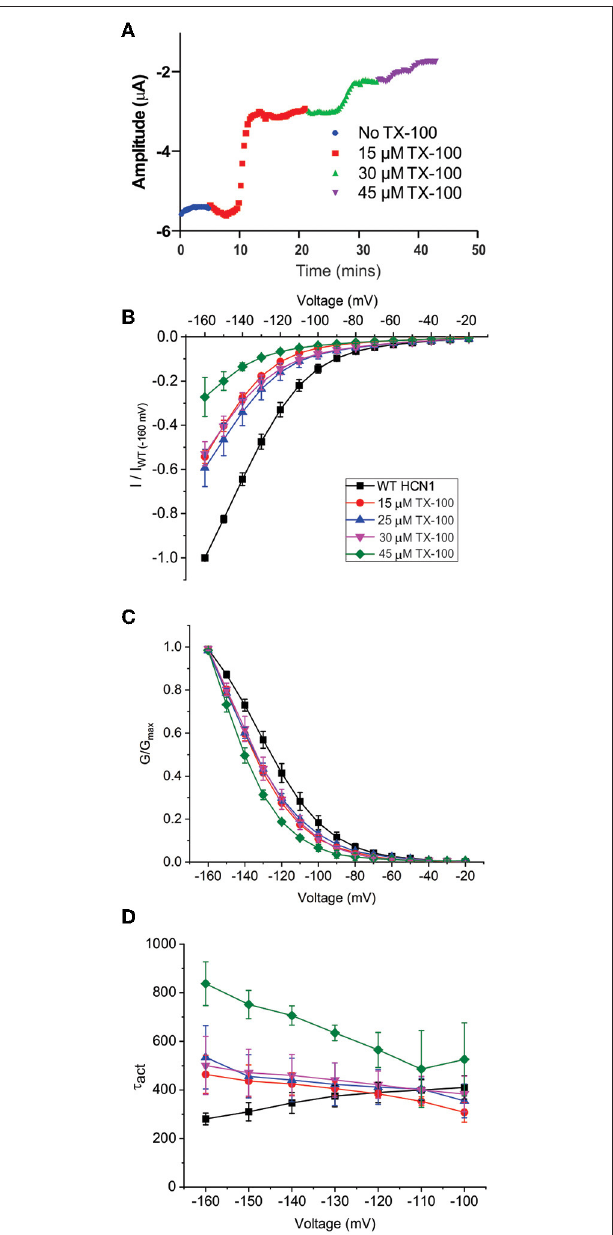
FIGURE 6 | Changes in membrane fluidity do not account for cannabinoid regulation of HCN1. Membrane fluidity was altered by the addition of Triton X-100 (TX-100) to the bath solution. (A) Representative time course of the steady-state current following the application of TX-100 at different concentrations, indicating that increasing membrane fluidity decreases HCN1 channel activity. However, this decrease in HCN1 current occurs more rapidly (within 1–2min) than the decline observed with THC (which occurs over the course of 10–30min). (B) Current-voltage relationship of HCN1 upon the addition of 0, 15, 25, 30, and 45 µ M TX-100 normalized to maximal current (I WT( − 160mV) ). (C) TX-100 induces a − 10 to − 15mV hyperpolarizing shift in the steady-state voltage-dependence of HCN1, which does not occur when THC or CBD is applied. (D) HCN1 activation kinetics are uniquely affected by TX-100, with membrane fluidity having a greater impact on slowing channel activation with more hyperpolarization of the membrane potential (3 < n < 9 per condition; P <